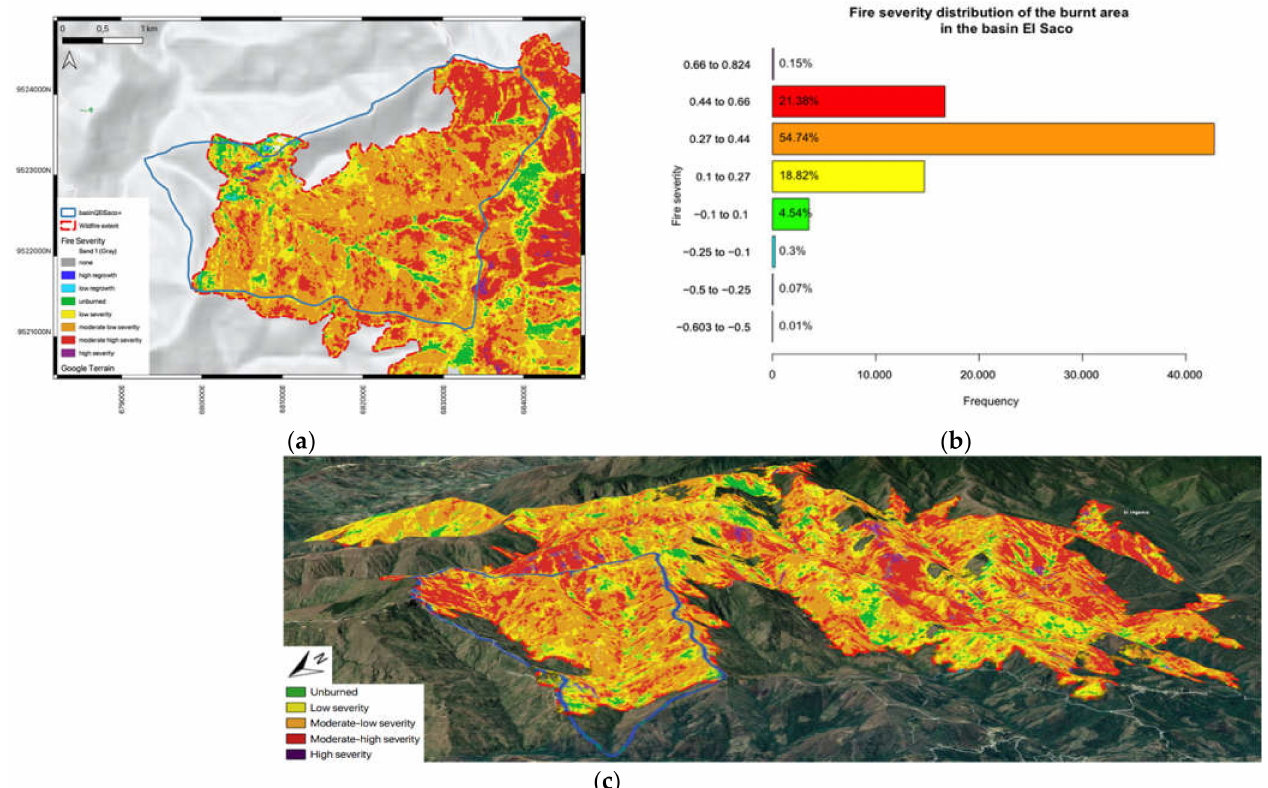
Figure 4. ( a ) Fire severity after the wildfire in September 2019 at the El Saco basin, canton Quilanga/Ecuador. Base map: Google Terrain; ( b ) Distribution of the fire severity within the burnt area of El Saco at the canton Quilanga/Ecuador after the wildfire in September 2019; ( c ) Overview of the wildfire area 2019 from the viewpoint Quilanga in Google Earth